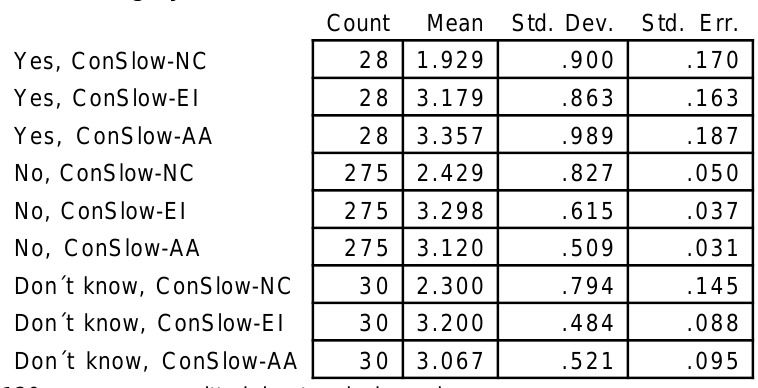
Means Table for ConSlow Effect: Category for ConSlow *